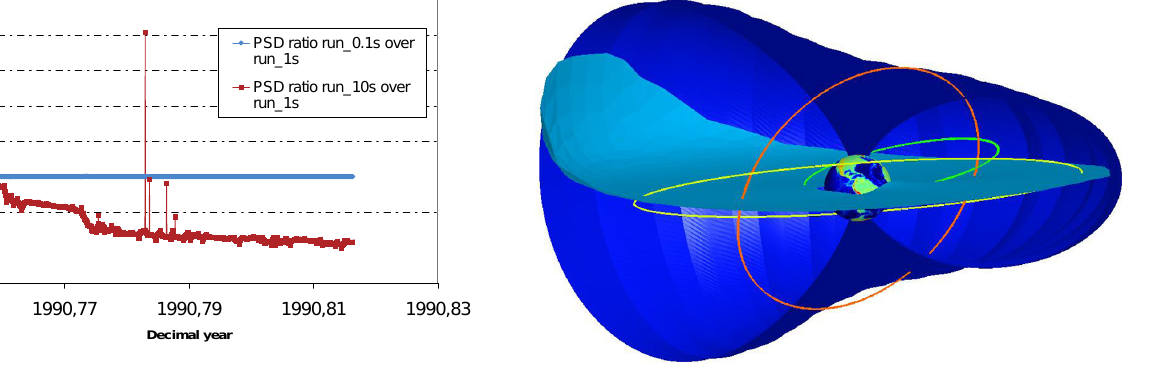
Fig. 3. Orbits along with data sets are considered for the simulation as of 5 October 1990. Data assimilated are taken along LANL GPS NS18 (red) and LANL GEO 1989 046 (yellow). Test data set is taken along CRRES spacecraft